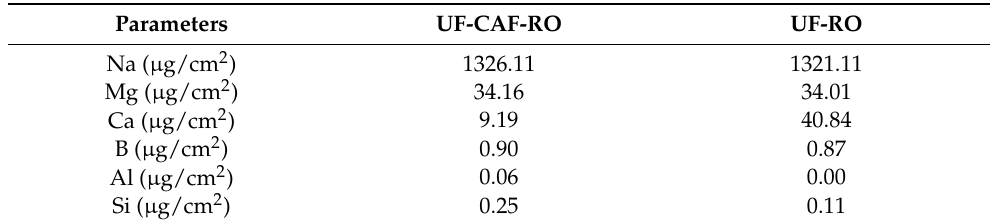
Table 3. Comparative analysis of the inorganic ions fouled on the RO membranes in the 2nd evaluation.